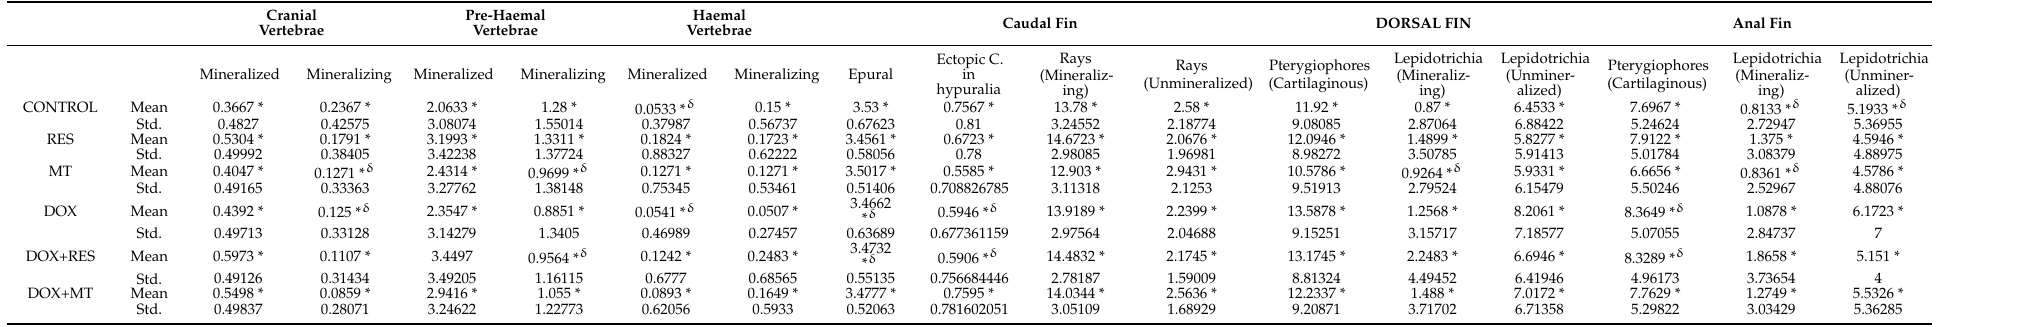
Table 5. Meristic character